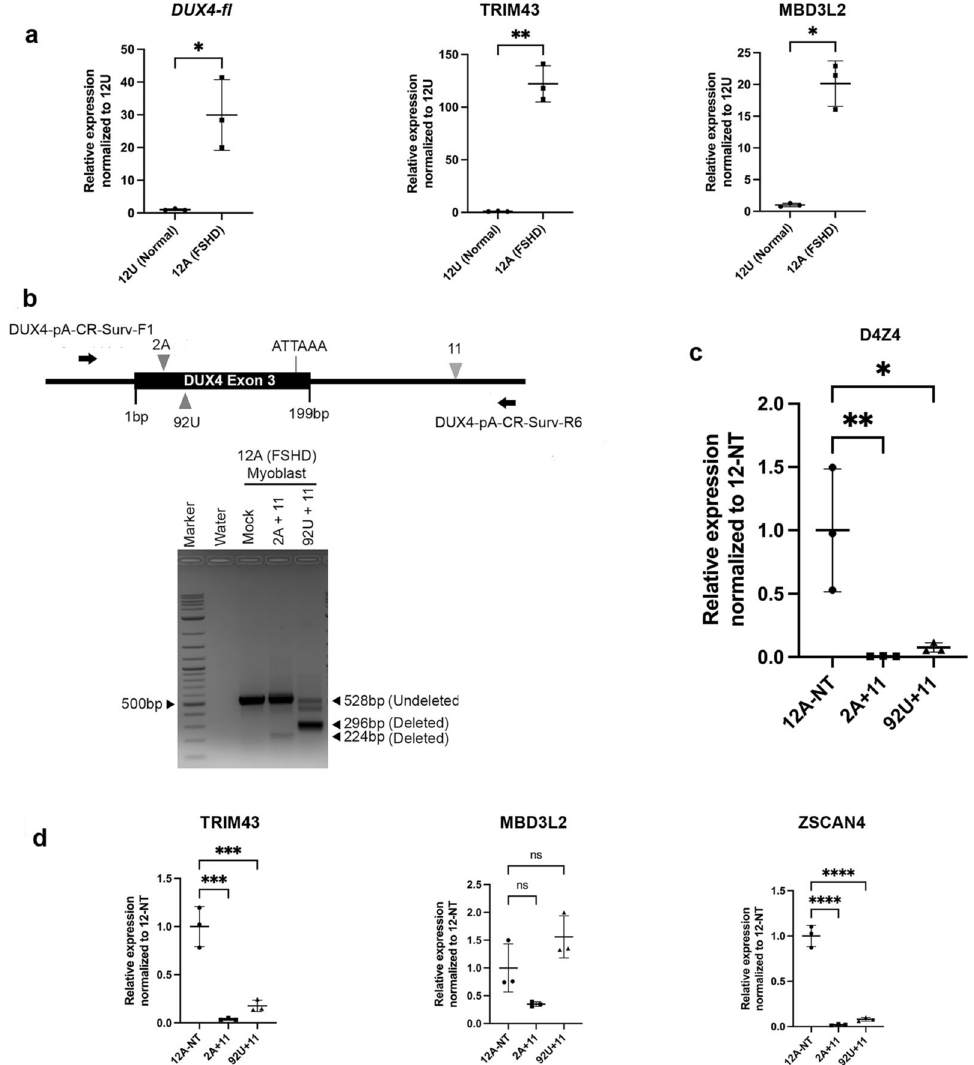
Figure 3. CRISPR-Cas9 mediated targeting of pathogenic poly-A and downregulation of DUX4 and target genes in patient myoblasts. ( a ) qRT-PCR analysis for DUX4-fl (left) and target genes TRIM43 and MBD3L2 in unaffected and patient hTERT immortalized myoblasts. Transcript levels are expressed as fold change normalized to expression level in unaffected (12U) myoblasts, relative to GAPDH expression. All values are obtained by averaging results from triplicates for each sample. Statistical significance is indicated (* p ≤ 0.05; ** p ≤ 0.01). ( b ) Top panel shows schematic of for the dual-sgRNA PCR based deletion assay with two suitable combination of sgRNAs upstream (CR-2A or CR-92U) and downstream (CR-11) of the poly-A site, indicated by triangles. CR-92U binds to the antisense strand, as indicated by inverted triangle. The position of primers used for PCR detection of cut and uncut products are shown as black arrows, along with their names. Bottom panel shows results of a trial deletion assay using abovementioned sgRNAs cloned in suitable lentiviral vectors, transduced in patient myoblast cells. Sample names are indicated on top. The expected size for undeleted and deleted PCR products is indicated on the right-hand side by black triangles. ( c ) qRT-PCR analysis for D4Z4 in patient (12A) control (NT) myoblasts, along with cells treated with different sgRNA combinations (named on the X-axis) targeting DUX4 poly-A. Transcript levels (Y-axis) are expressed as fold change normalized to expression level in control (NT) myoblasts, relative to ACTB expression. All values are obtained by averaging results from triplicates for each sample. Error bars represent standard deviation (n = 3). Statistical significance is indicated (* p ≤ 0.05; ** p ≤ 0.01). ( d ) qRT-PCR analysis for DUX4 target gene expression in patient myoblast controls and cells treated with different sgRNA combinations (named on the X-axis) targeting DUX4 poly-A. Transcript levels (Y-axis) for TRIM43 , MBD3L2 and ZSCAN4 are expressed as fold change normalized to expression level in control (NT) patient myoblasts, relative to ACTB expression. All values are obtained by averaging results from triplicates for each sample. Statistical significance is indicated (*** p ≤ 0.001; **** p ≤ 0.0001; ns no significant difference; p > 0.05). Schematic diagrams were generated using Microsoft PowerPoint 16.48 (https:// www. micro soft. com) and Adobe Photoshop 21.0.1 (https:// www. adobe.